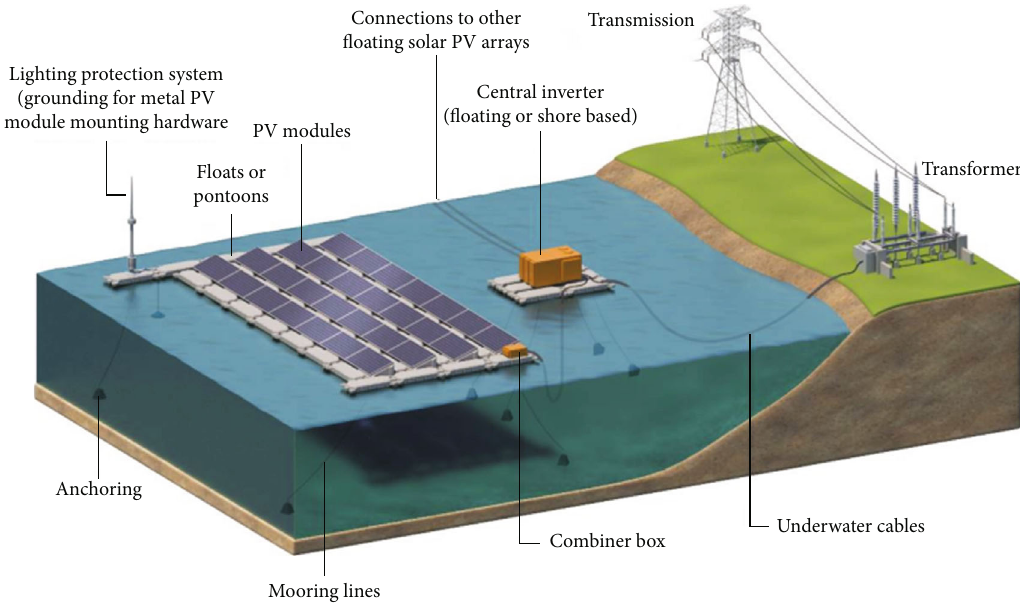
Figure 1: Schematic diagram of a typical large-scale FPV power plant